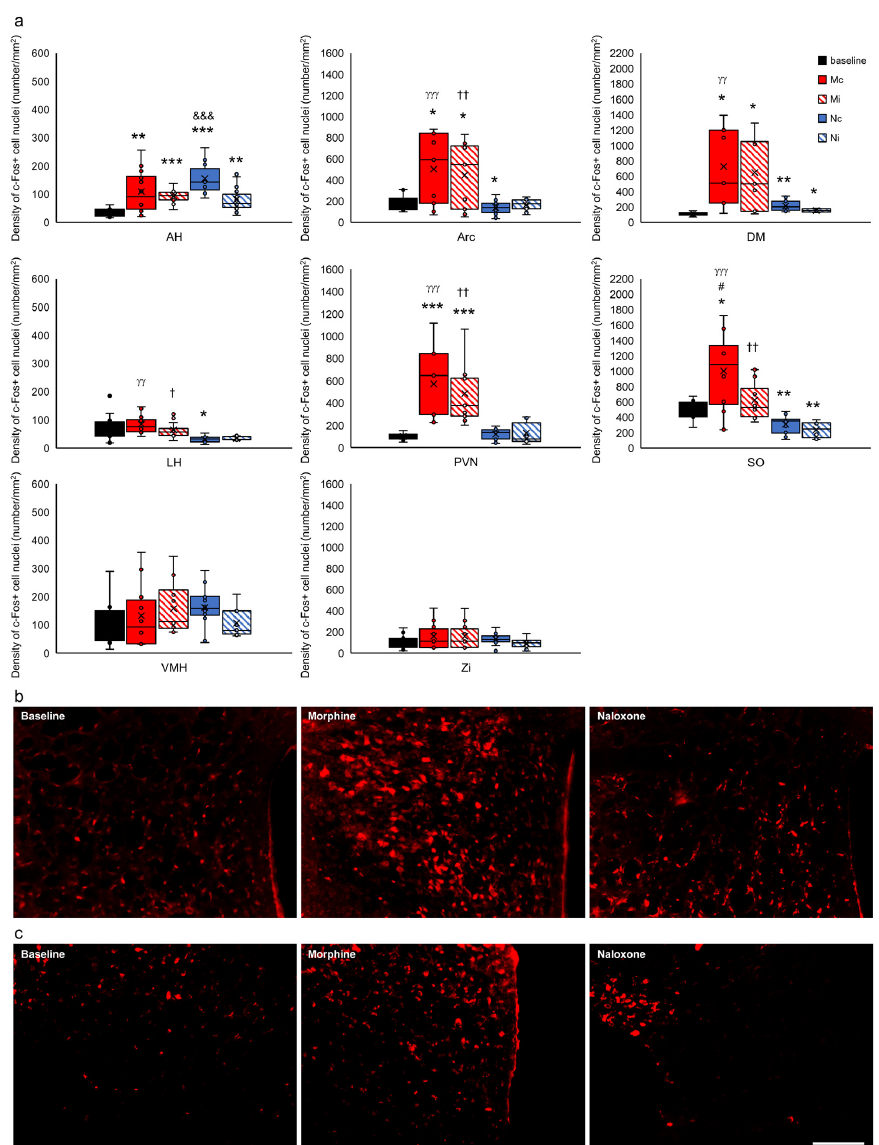
Figure 11. Density of c-Fos+ cell nuclei (number/1 mm 2 ) in select structures of the hypothalamus and subthalamus in the brains of rats that were subjected to VTA electrical stimulation (Es-VTA) only (baseline group, n = 5) (black-filled bars) and in the brains of rats administered Es-VTA and a one-time injection of morphine (1.5 µ g) or naloxone (25.0 µ g) injected into the PPN in the contralateral (Mc, n = 5, red-filled bars; Nc, n = 6, blue-filled bars) and ipsilateral hemispheres (Mi, n = 5, red-hatched bars; Ni, n = 6, blue-hatched bars) ( a ). Representative photomicrographs of c-Fos-labeled neurons in the PVN ( b ) and Arc ( c ) structures are shown. Scale bar = 100 µ m (white line: right lower corner of the last photo, panel ( c )). Tukey’s post hoc test: * p < 0.05, ** p < 0.01, and *** p < 0.001 indicate a significant difference between the baseline and other experimental groups (Mc, Mi, Nc, and Ni groups); # p < 0.05 indicate a significant difference in the morphine groups between different injection site: contra- or ipsilateral hemispheres (Mc vs. Mi group); γγ p < 0.01, γγγ p < 0.001 indicate a significant difference in the contralateral side groups between different injection drug: morphine or naloxone (Mc vs. Nc group); † p < 0.05, †† p < 0.01 indicate a significant difference in the ipsilateral side groups between different injection drug: morphine or naloxone (Mi vs. Ni group); &&& p < 0.001 indicate a significant difference in the naloxone groups between different injection site: contra- or ipsilateral hemispheres (Mc vs. Mi